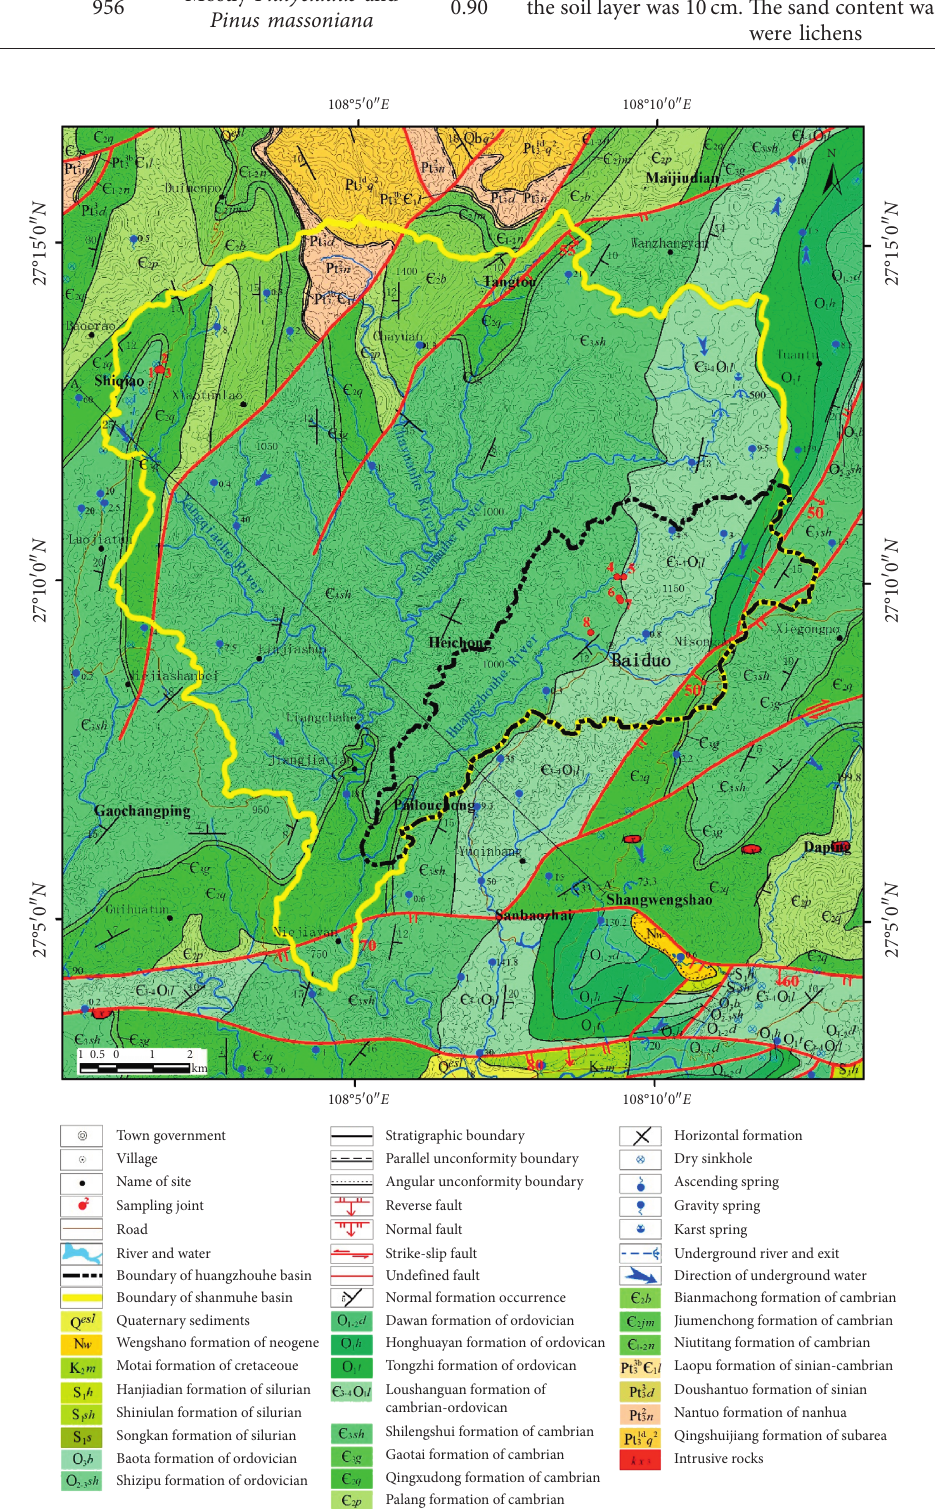
Figure 3: The location of the sampling sites on the geological